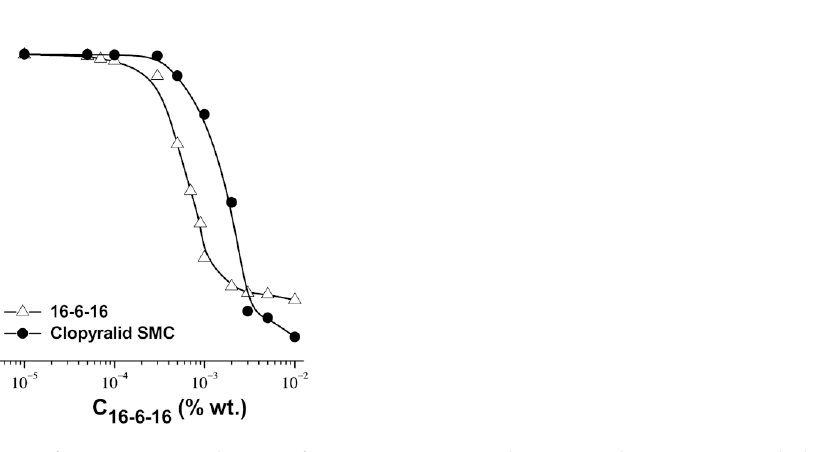
Figure 2. Surface tension isotherms of 16-6-16 aqueous solutions in the presence and absence of clopyralid at 25 ◦